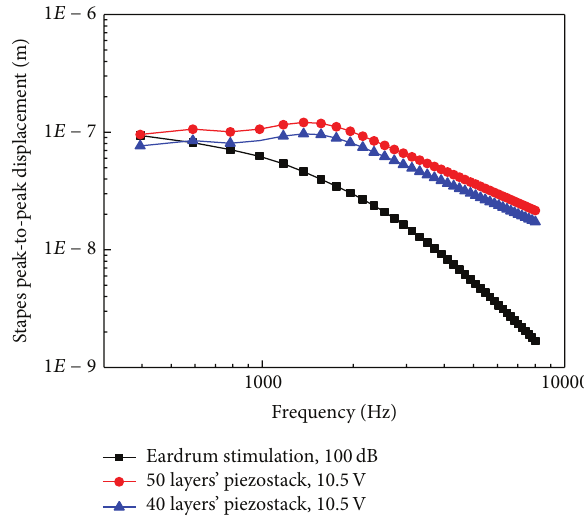
Figure 8: Stapes displacements from acoustic stimulation (100dB SPL) and piezoelectric stack transducer’s stimulation at 10.5 V RMS.